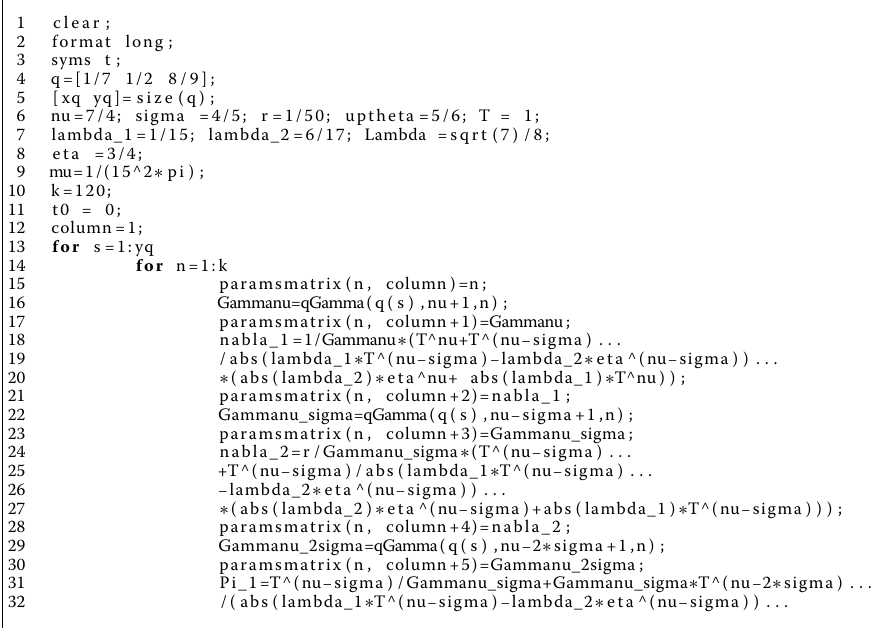
Algorithm 1 (MATLAB lines for calculation ∇ i , (cid:14) i , and (cid:21) ,